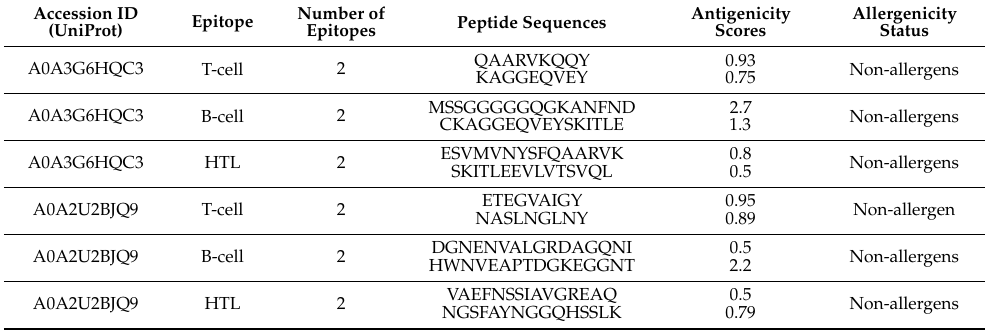
Table 2. Showing the antigenicity- and allergenicity-based shortlisted epitopes against each target protein of Alcaligenes faecalis